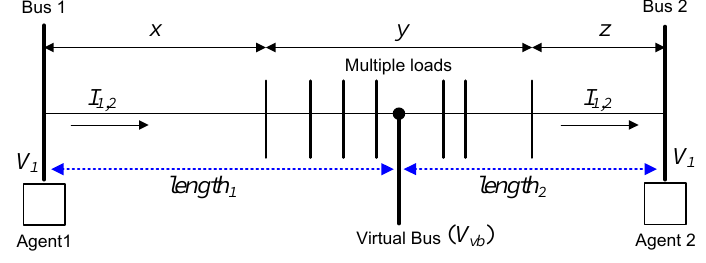
Figure 6. The location of virtual bus.